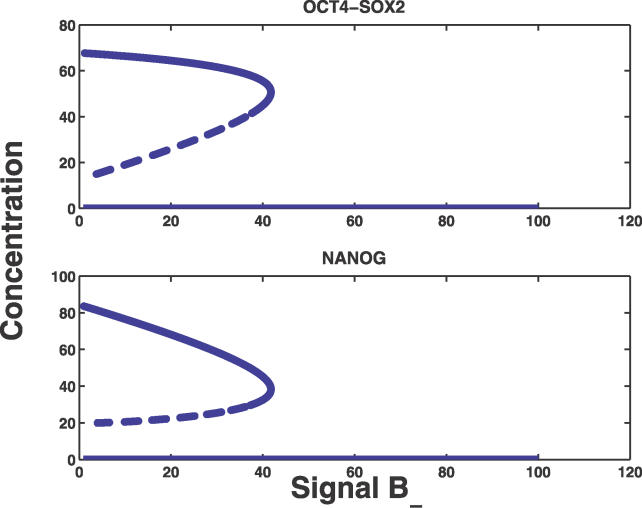
Steady State Concentrations of OCT4–SOX2 and NANOG as Functions of the Signal B
−
At the threshold B ≈ 41 the system switches off and remains permanently off even when B
− is removed.